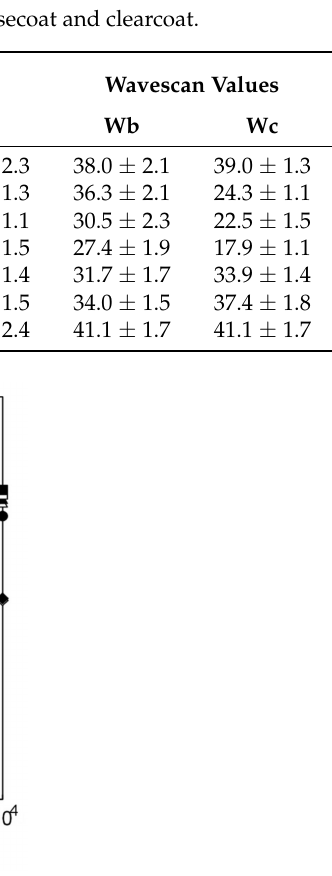
Figure 15. Shear rate dependence of viscosity of solventborne